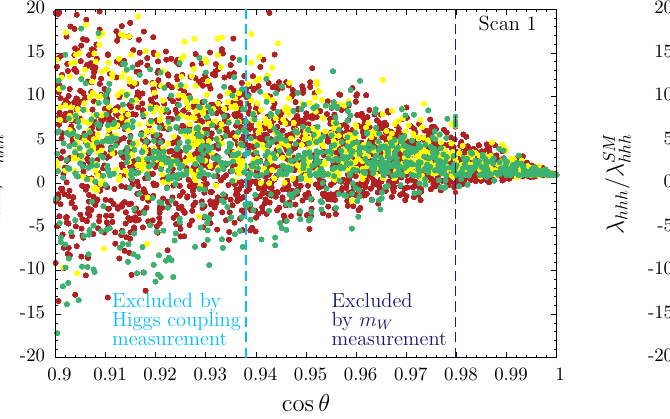
Fig. 6 Left: The trilinear Higgs self-coupling normalised to the SM reference value for scan 1 (strongly coupled regime). The red/yellow/green points correspond, respectively, to unsta-